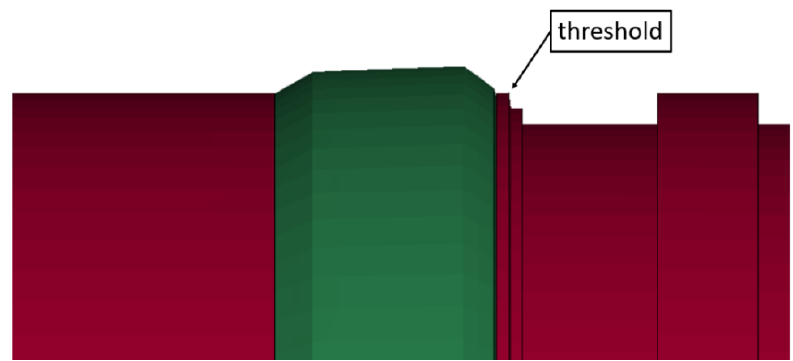
Figure 14. Barrel resistance pressure as function of projectile displacement.